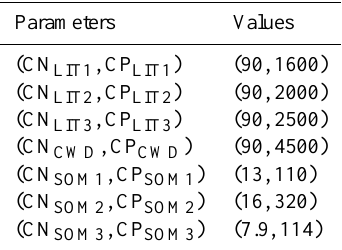
Table 2. Parameter values used in this study. These values are based on syntheses from Parton et al. (1988), Yang et al. (2014), and Zhu et al.